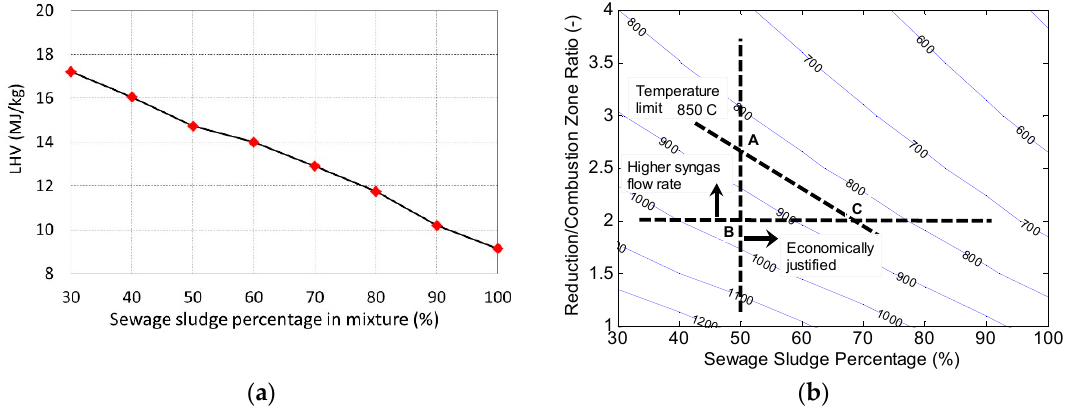
Figure 6. ( a ) Calorific value (LHV) of the sewage sludge-Virginia Mallow mixture; ( b ) X ratio as Reduction/Combustion zone ratio vs. sewage sludge percentage in the total fuel mixture to the gasifier.